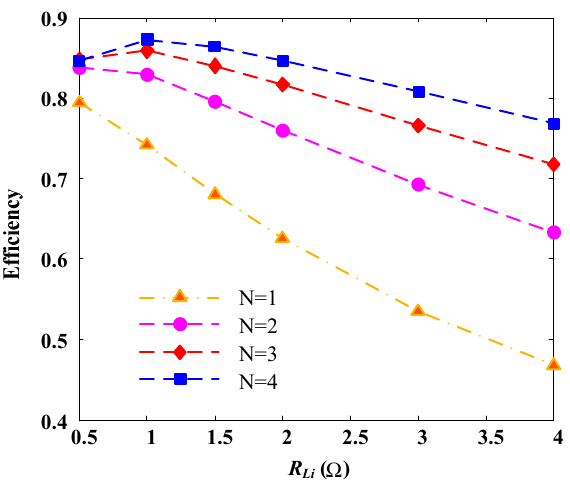
Figure 12. The change in the efficiency of the system with load resistance.